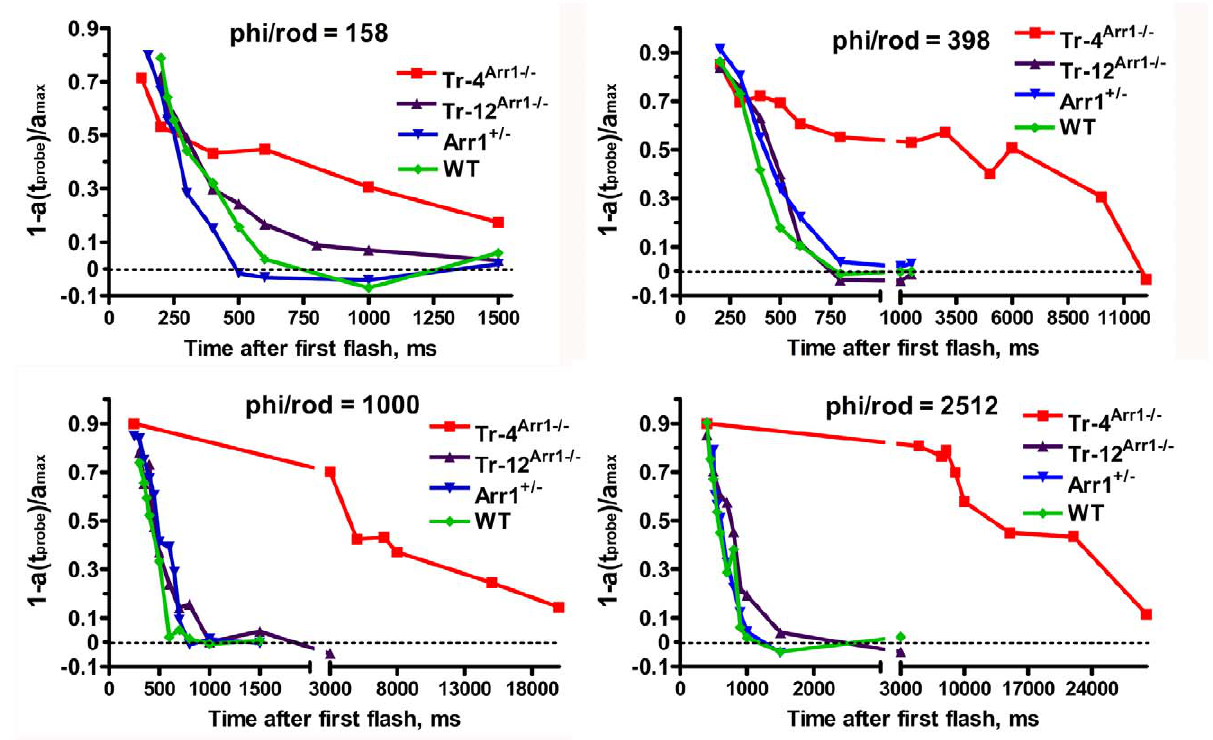
Figure 1. Reduced arrestin-1 expression slows down photoresponse recovery. The intensities of the first (desensitizing) flashes were 2 0.8, 2 0.4, 0, or + 0.4 log cd*s/m 2 and second (probe) flash was 0.65 log cd*s/m 2 . The a-wave elicited by the probe flash was plotted as a function of time elapsed after the first flash. Representative recovery curves for indicated genotypes and strengths of desensitizing flash are shown. The interval between the two flashes was varied from 200 to 120,000 ms. The results for desensitizing flash of 2 0.4 log cd*s/m 2 were reported previously [10], and are shown here for comparison. Phi/rod, photoisomerizations/rod. [59]